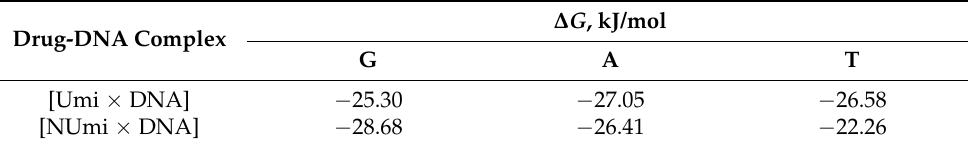
Table 4. Values of the Gibbs free energy ( ∆ G ) for Umi or NUmi with dsDNA complex calculated for G, A, and T heterocyclic